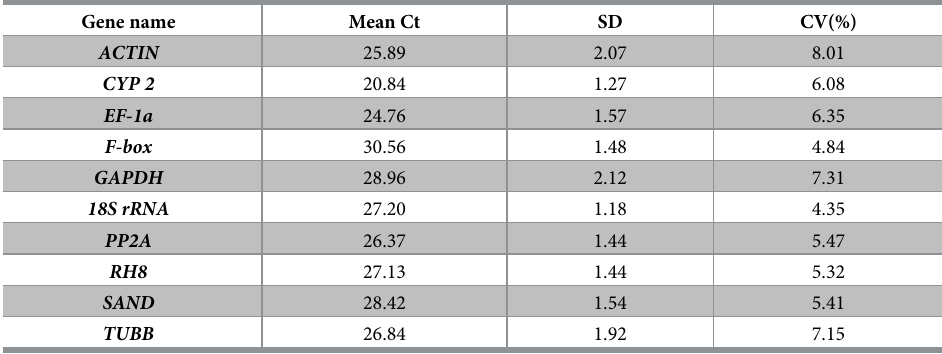
Table 3. The value of average Ct, standard deviation (SD) and coefficient of variation (CV) were calculated from the all data for this